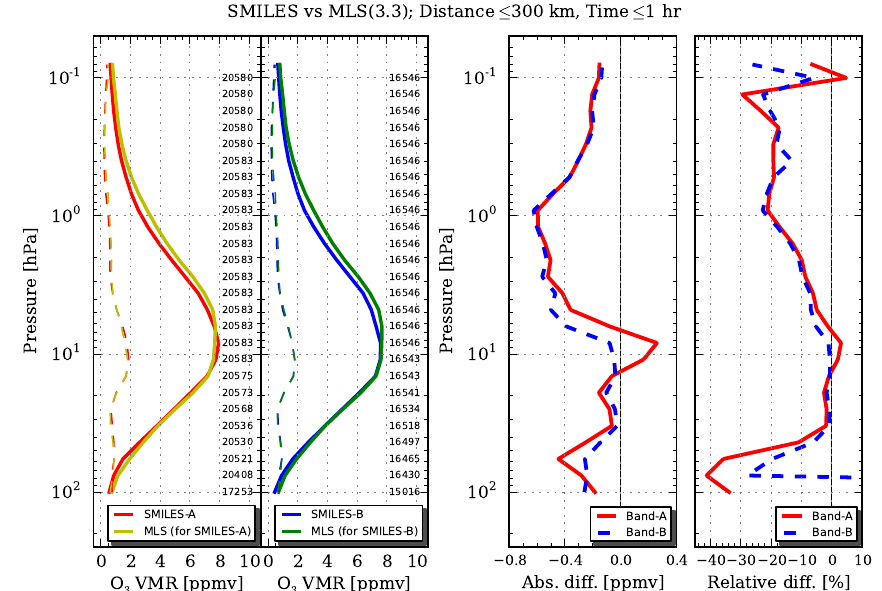
Fig. 12. Left panel: mean O 3 VMR values for SMILES and ozonesonde measurements (solid lines). The SMILES measurements for Band- A (red line) and Band-B (blue line) are compared separately. Dashed lines represent the associated 1 σ standard deviations for each dataset. Numbers of coincident pairs are indicated at the right side of each panel. Middle panel: mean absolute difference for observed O 3 between SMILES and ozonesonde calculated by Eq. (2). The comparisons for Band-A and for Band-B measurements are shown with the red solid and blue dashed profiles, respectively. Right panel: mean relative difference for observed O 3 between SMILES and ozonesonde calculated by Eq. (3).